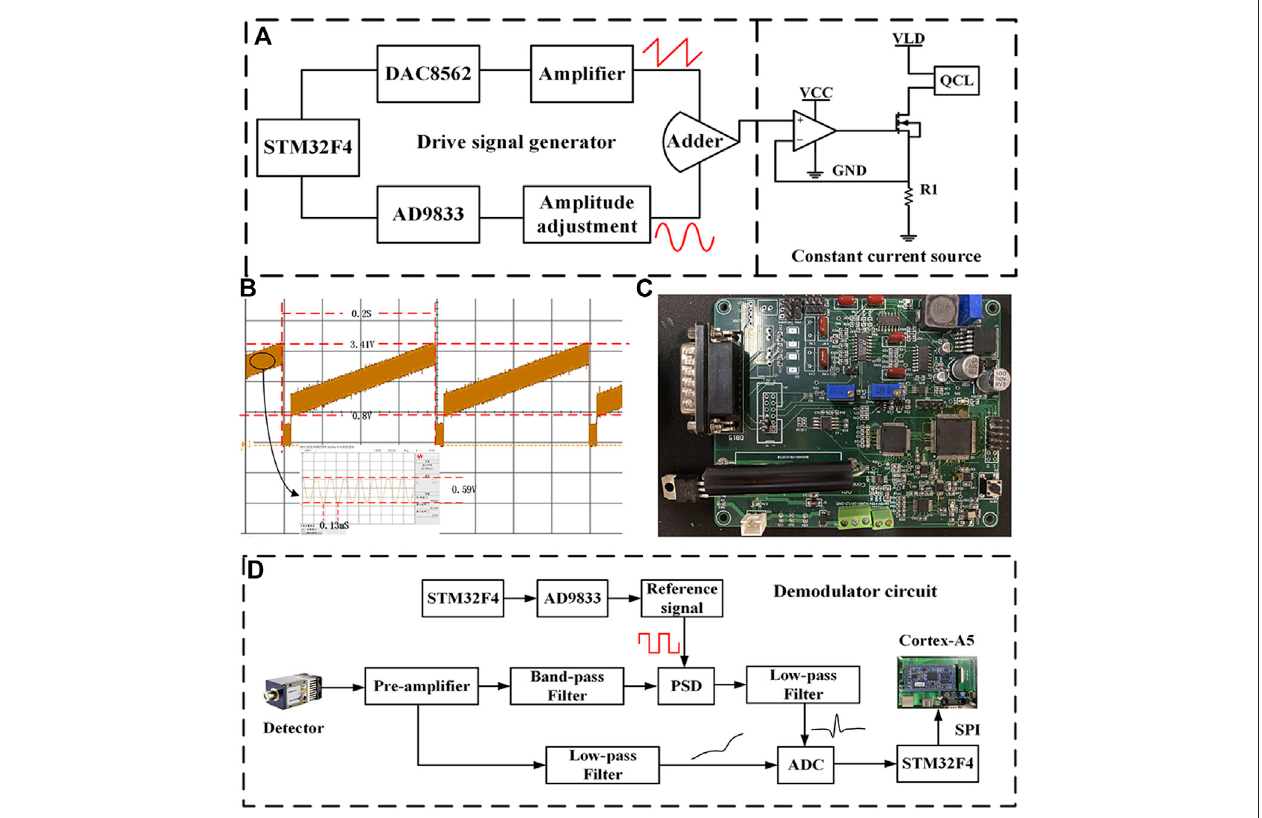
FIGURE 3 | (A) Block diagram of QCL driver circuit. (B) Voltage driver signal waveform. (C) Photograph of the self-developed board-level QCL driver and demodulation circuit. (D) Block diagram of demodulation